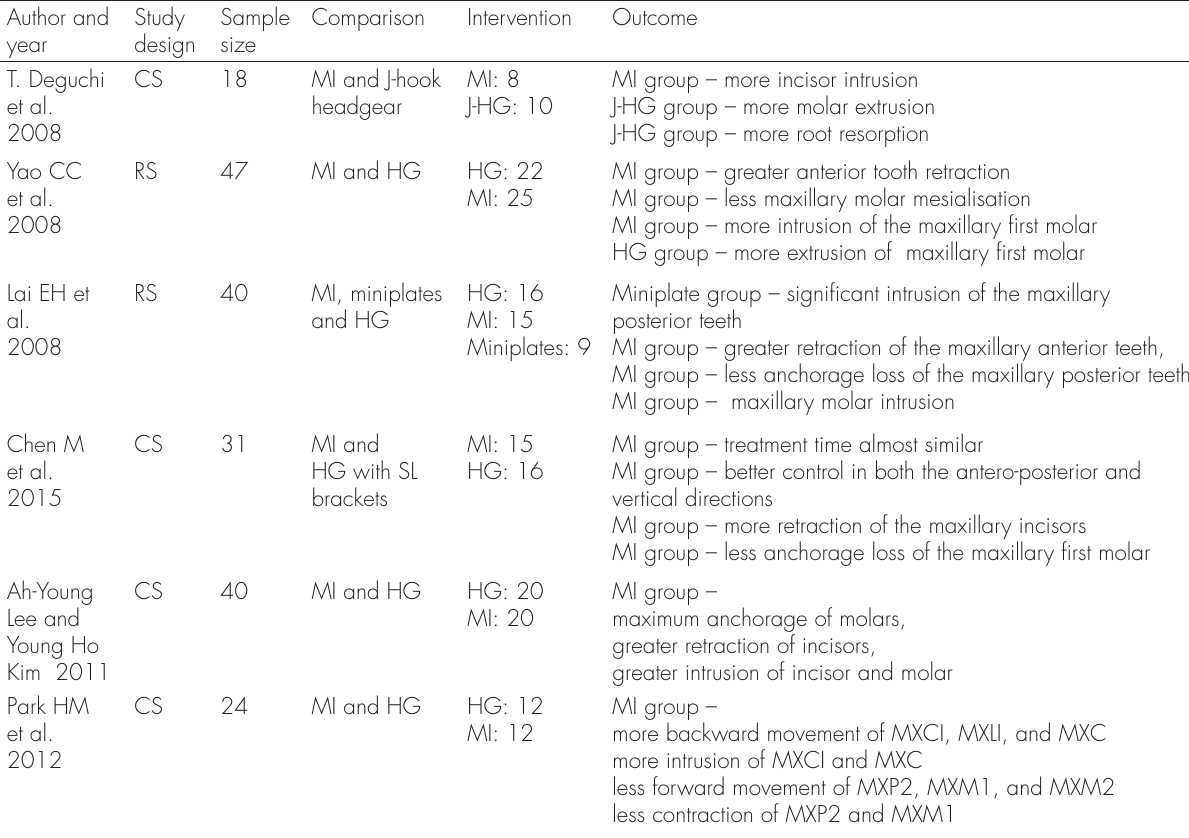
Table VI. Mini-implants compared with extra oral anchorage